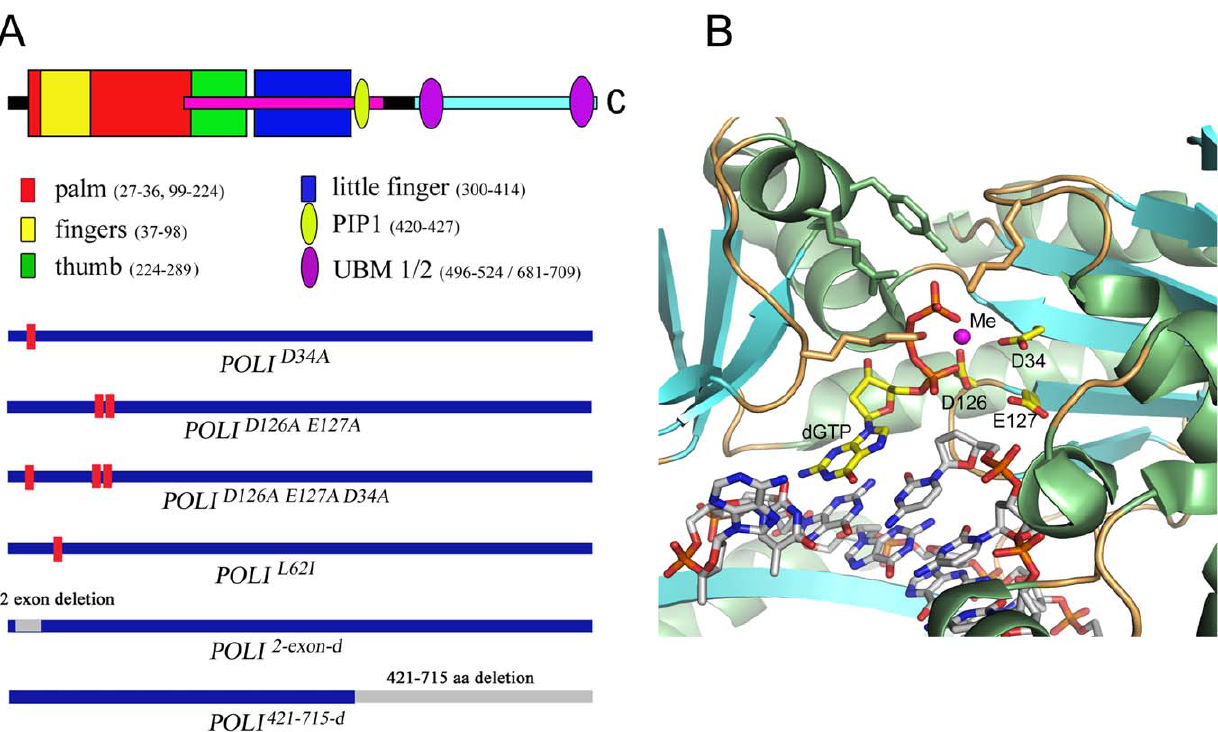
Figure 1. Structure of Pol i and the variants studied. A. Upper half. The schematic domain structure of Pol i is shown (PIP is the protein interaction domain, UBM – ubiqutin-binding motif). Lower half. The Pol i mutant variants were used in the study (Red bars on the thick blue line representing Pol i show the positions of amino acid changes in polymorphic variants of Pol i . Grey bars indicate deletions for truncated Pol i variants): hPOLISc 2exon-d (Pol i 2exon-d ) – Pol i variant with a deletion of exon 2 (encoding for amino acids 14-55) representing an alternative splice variant of human and mouse Pol i ; hPOLISc D34A (Pol i D34A ) and hPOLISc D126A/E127A (Pol i D126A/E127A ) – ‘‘catalytically dead’’ Pol i variants created as amino acid substitutions of evolutionary conservative Asp34 or Asp126 and Glu127 to Ala; hPOLISc D34A/D126A/E127A (Pol i D34A/D126A/E127A ) – a triple ‘‘catalytically dead’’ Pol i variant with amino acid substitutions of Asp34, Asp126 and Glu127 to Ala; hPOLISc L62I (Pol i L62I ) – Pol i variant with a substitution of evolutionary polymorphic amino acid Leu62 to Ile; hPOLISc 42I-612-d variant with a deletion of the C-terminal half of Pol i is shown to illustrate what minimal part retains enzymatic activity and whose crystal structure has been determined. B. Pol i active site. A close view at the Pol i active site in ternary complex with DNA (template T) and incoming dGTP (3gv8). Pol i and DNA molecules are represented as cartoon and sticks, respectively. The incorporated nucleotides and active site residues Asp34, Asp126 and Glu127 are represented by sticks and highlighted with yellow carbons. The side chains of phosphate-binding residues are also shown as sticks. The metal ion is drawn as a magenta